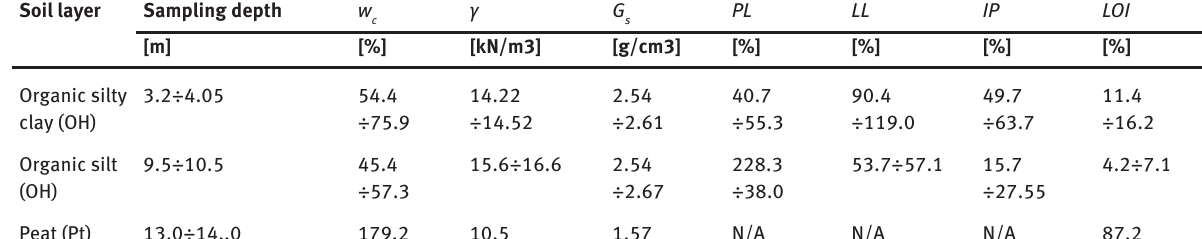
Table 1: Selected index properties of the Vistula Marshlands soft soils. Soil layer